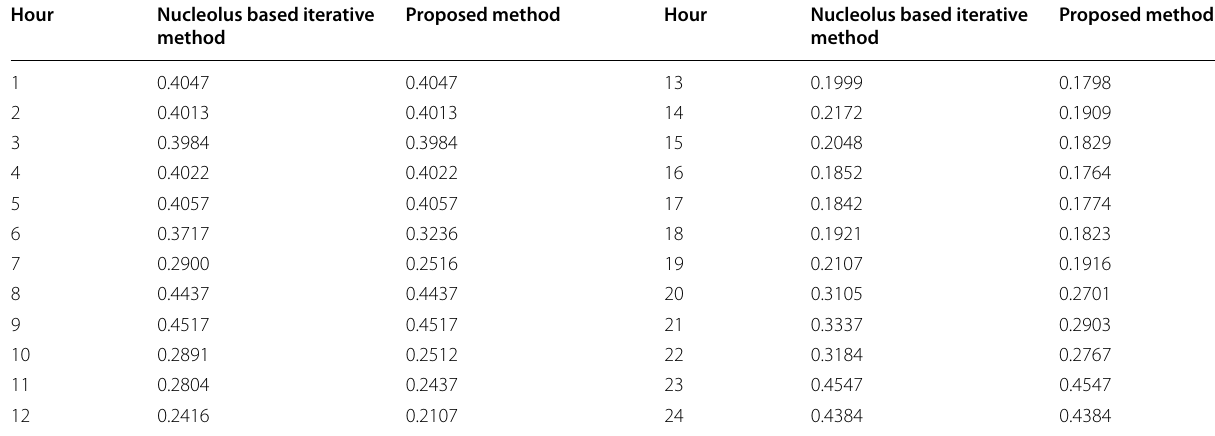
Table 6 Comparison in terms of active power loss (MW) Hour Nucleolus based iterative Proposed method Hour Nucleolus based iterative method